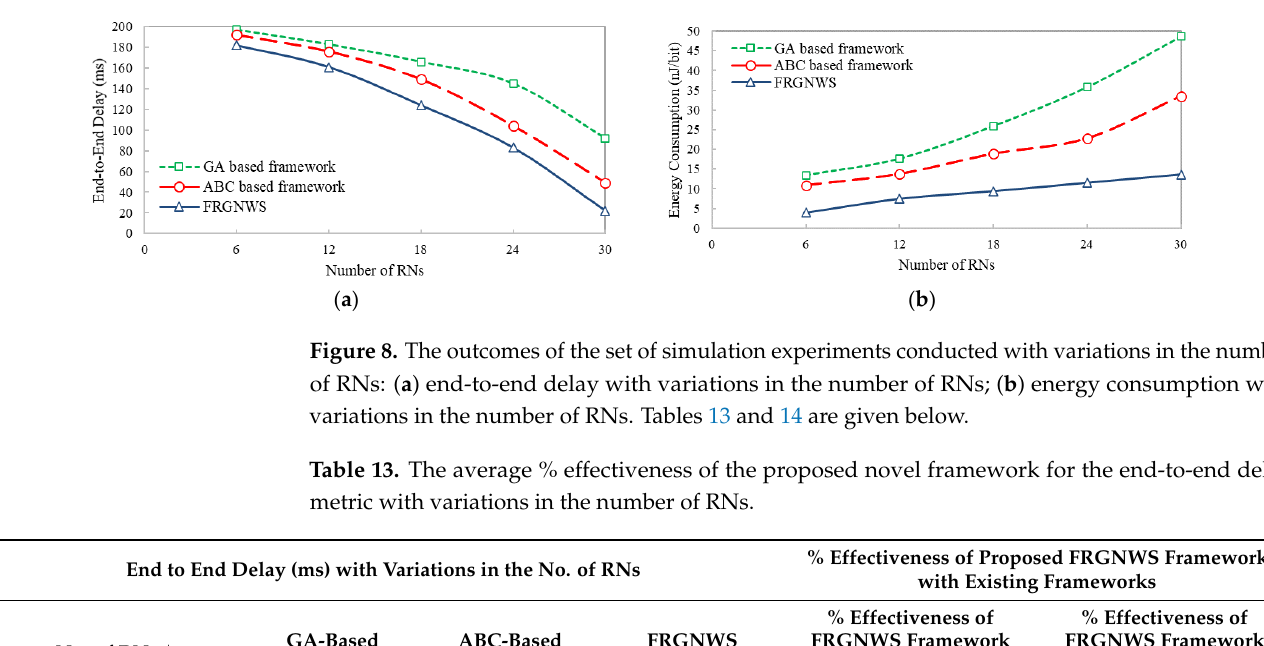
Table 13. The average % effectiveness of the proposed novel framework for the end-to-end delay metric with variations in the number of RNs.